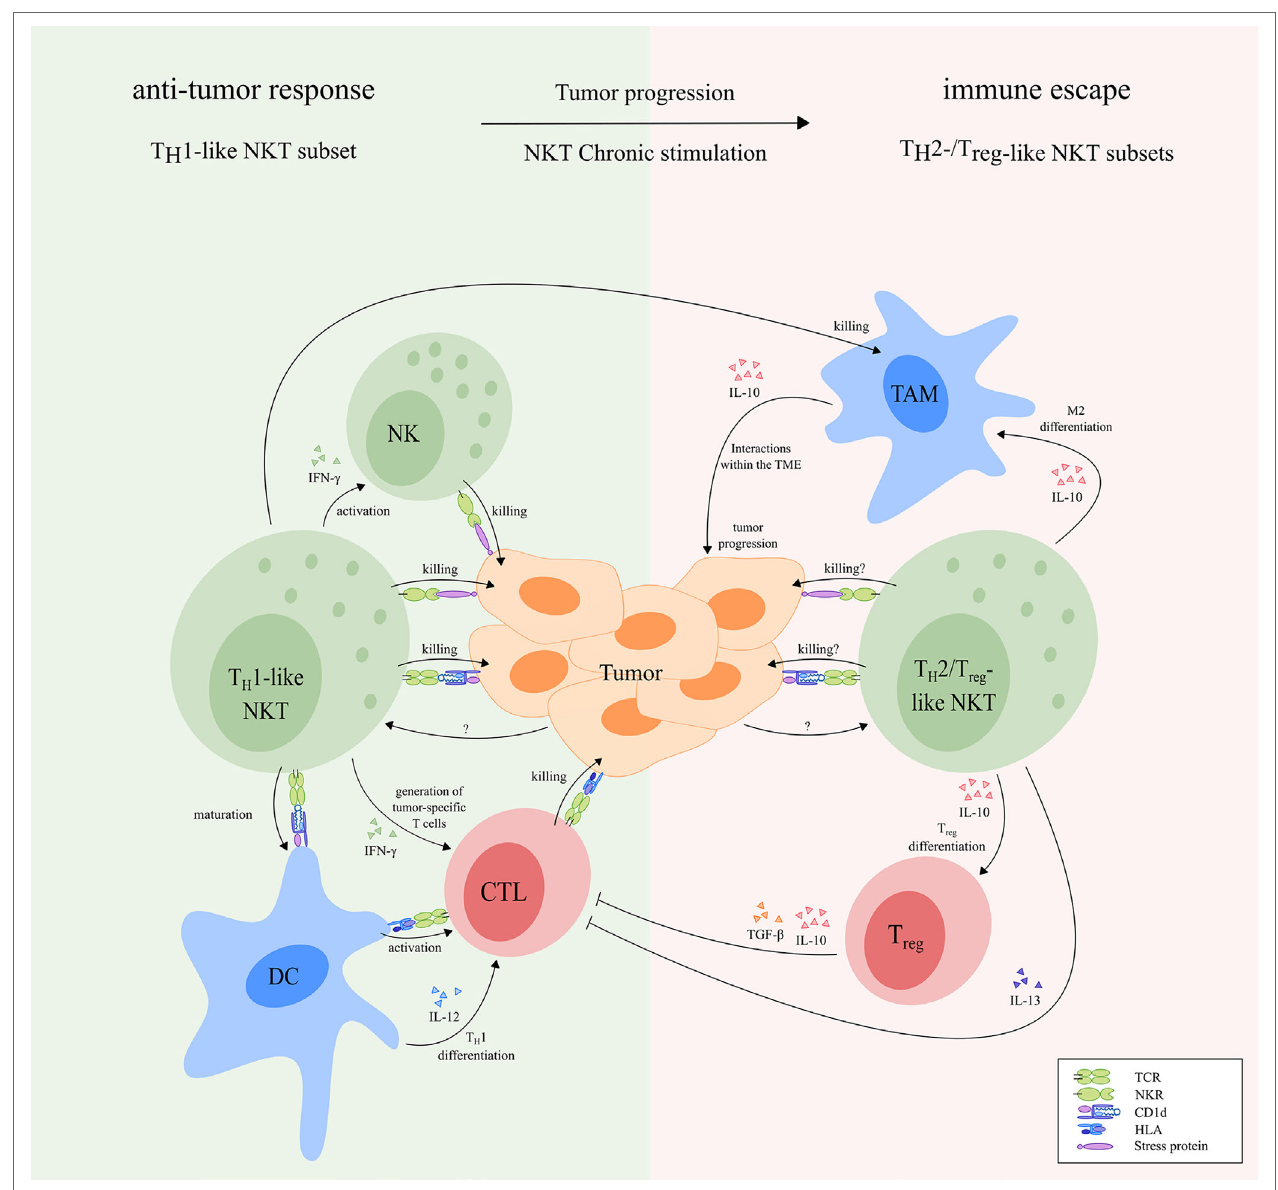
FigURe 5 | The dual role of NKT cells in cancer. During early tumor development, T H 1-like NKT cells may induce an effective antitumor response via direct killing of tumor cells upon interaction with stress proteins and CD1d molecules, respectively. In addition, activated T H 1-like NKT cells secrete high amounts of IFN- γ , which may lead to generation of tumor-specific CD8 + cytotoxic T cells and rapid activation of NK cells that kill tumor cells. Besides, activated NKT cells can induce maturation of DC in a CD1d-dependent manner, resulting in T H 1 differentiation and activation of tumor-specific CD8 + T cells. Finally, activated T H 1-like NKT cells can kill M2-polarized TAM in a CD1d-dependent manner, thereby preventing their tumor growth-promoting effects. During tumor progression, T H 1-like NKT cells can become anergic and may switch to T H 2-/T reg -like NKT cell subsets that facilitate tumor progression and immune escape. For instance, T reg -like NKT cells can promote differentiation of M2-polarized TAM and T regs . T regs inhibit tumor-specific T cells via cell–cell interactions, and secretion of IL-10 and TGF- β . In addition, T H 2-like NKT cells can inhibit tumor-specific T cells via production of large amounts of IL-13. T H 2- and T reg -like NKT cell subsets might be able to kill tumor cells, either via CD1d-dependent or CD1d-independent mechanisms. However, overstimulated NKT cells produce large amounts of immunosuppressive cytokines, resulting in a net effect of immunosuppression. Receptors that are known to be involved in NKT cell-mediated antitumor responses are indicated in the figure. The functional NKT cell subsets indicated in the figure can be both type I and type II NKT cells as illustrated in Figure 1 . Abbreviations: NKT, natural killer T; T H , helper T; NK, natural killer; DCs, dendritic cells; TAM, tumor-associated macrophages; T reg , regulatory T; TME, tumor microenvironment; NKR, natural killer receptor; TCR, T cell receptor; HLA, human leukocyte antigen.